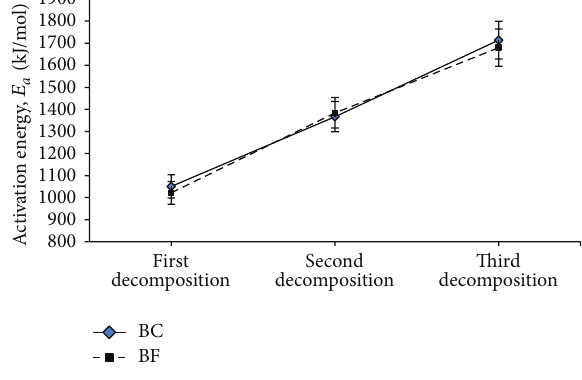
Figure 4: Activation energy of BF and CB samples before UV